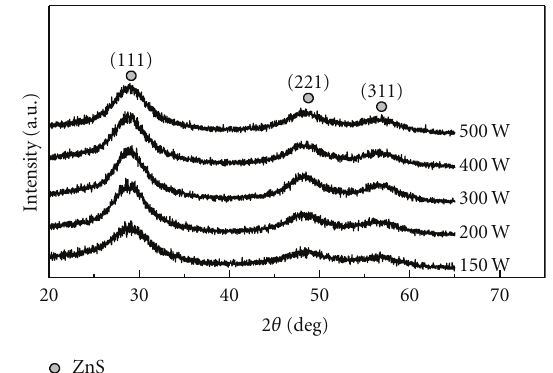
Figure 2: XRD pattern of 2-ethylhexanoic acid coated ZnS:Mn 2+ nanoparticles prepared using di ff erent microwave